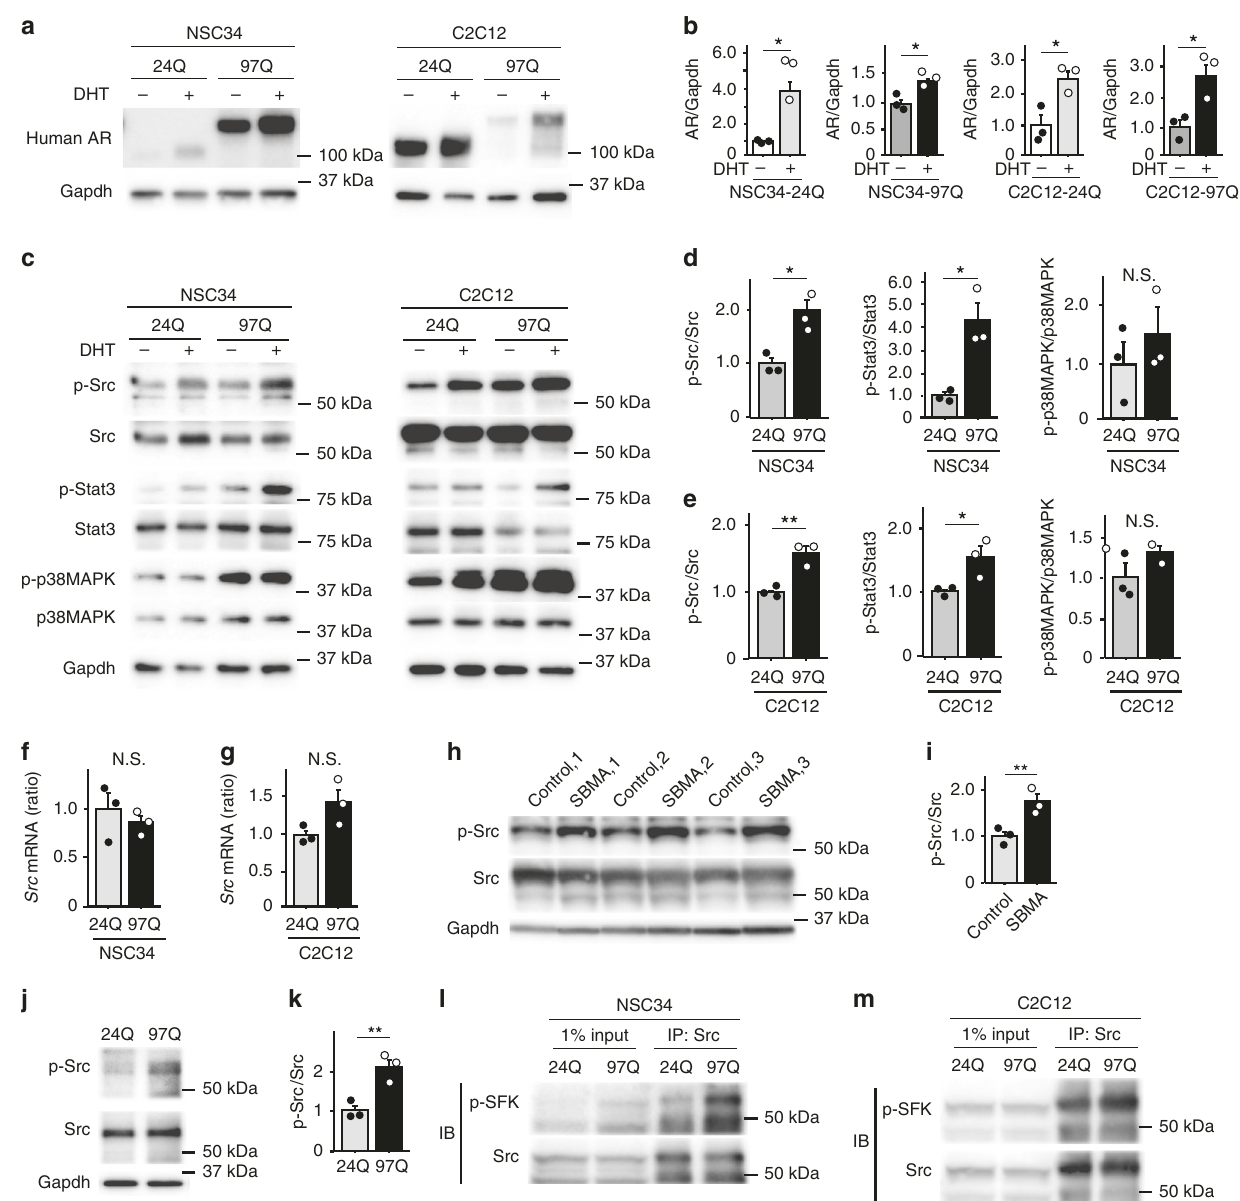
Fig. 2 Levels of phosphorylated Src, Stat3 and p38MAPK in cellular models of SBMA. a Immunoblots showing the levels of the human AR protein in NSC34 and C2C12 cells stably expressing AR-24Q or AR-97Q that were treated with or without DHT. b Quantitative densitometry analysis of AR levels in NSC34 and C2C12 cells stably expressing AR-24Q or AR-97Q that were treated with or without DHT ( n = 3 samples per group). c – e Immunoblots showing the levels of phosphorylated and total Src, Stat3, and p38MAPK proteins in AR-24Q cells and AR-97Q cells treated with or without DHT ( c ). Quantitative densitometry analysis of p-Src, p-Stat3 and p-p38MAPK levels in DHT-treated NSC34 ( d ) and C2C12 ( e ) cells stably expressing AR-24Q or AR-97 ( n = 3 samples per group). f , g The mRNA levels of Src in DHT-treated NSC34 ( f ) or C2C12 ( g ) cells stably expressing AR-24Q or AR-97Q ( n = 3 samples per group). h , i Immunoblots showing the levels of phosphorylated and total Src proteins in induced pluripotent stem cells (iPSCs) from patients with SBMA and healthy controls ( h ). Quantitative densitometry analysis of p-Src levels in iPSCs from patients with SBMA and healthy controls ( n = 3 samples per group) ( i ). j , k Immunoblots showing the levels of phosphorylated and total Src proteins in Hu5/KD3 cells overexpressing AR-24Q or AR-97Q ( j ). Quantitative densitometry analysis of p-Src levels in Hu5/KD3 cells overexpressing AR-24Q or AR-97Q ( n = 3 samples per group) ( k ). l , m NSC34 ( l ) and C2C12 ( m ) cell lysates were immunoprecipitated with a Src-speci fi c antibody and immunoblotted with an antibody against Src family proteins. Error bars indicate the s.e.m. * p < 0.05 and ** p < 0.01, un p aired two-sided t -test ( d – g , i , k ). DHT, dihydrotestosterone. N.S., not signi fi cant. Source data are